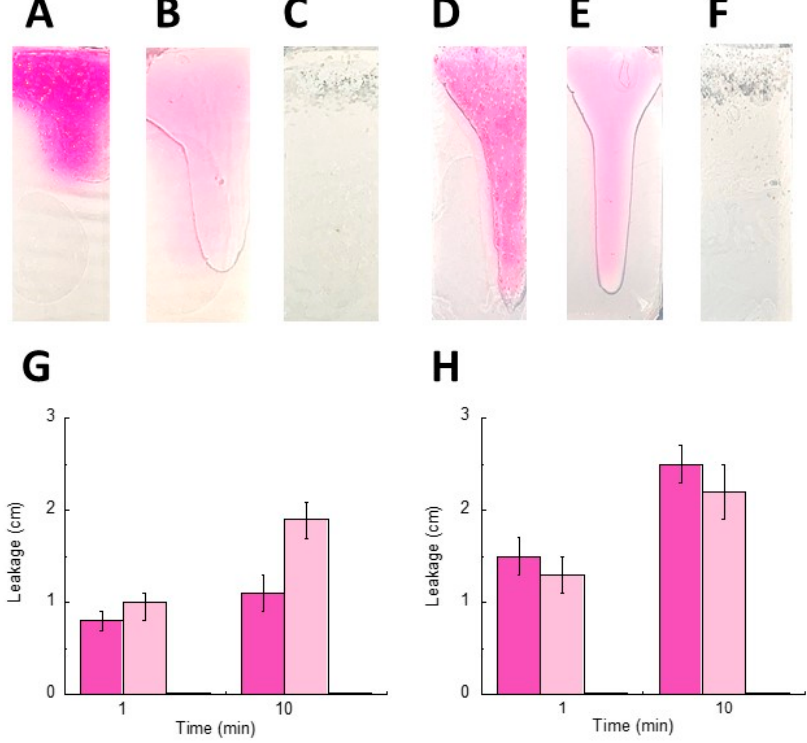
Figure 4. Comparative leakage test performed on formulations colored by rhodamine for imaging.